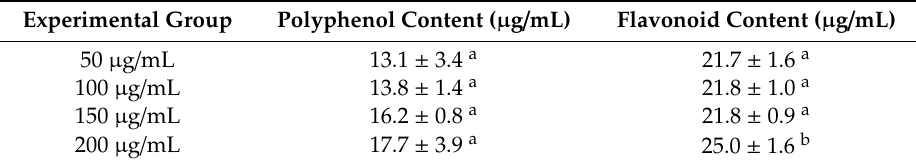
Table 1. Polyphenol and flavonoid content of Glycyrrhiza uralensis extract. Experimental Group